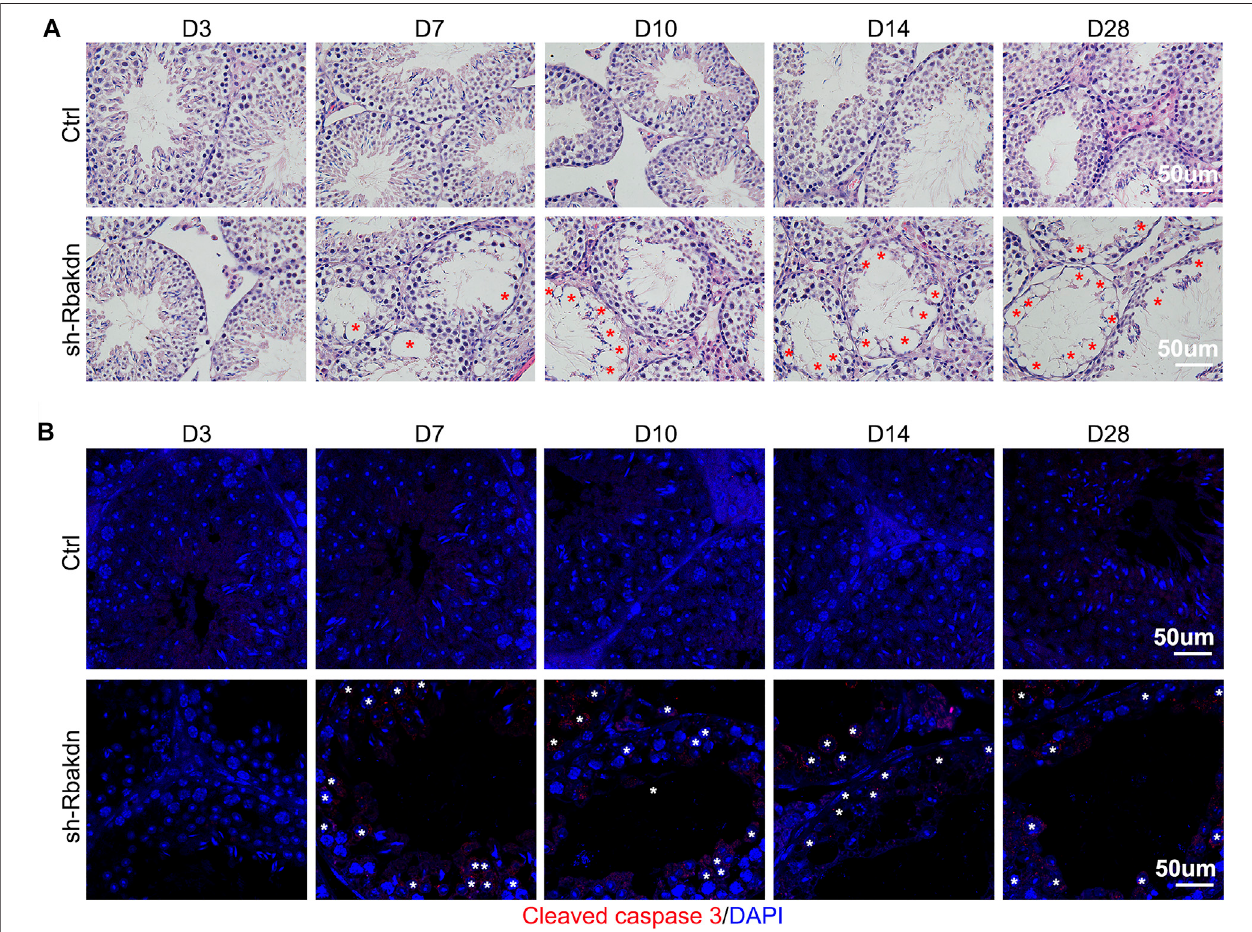
FIGURE 4 | Knockdown of Rbakdn in the testis increased apoptosis of spermatocytes. (A) HE staining of mouse testes after injection of lentivirus-mediated Rbakdn-shRNA at D3,D7, D10,D14, and D28.The redasterisksindicate thevacuoles. (B) Theexpression oftheapoptosis-related protein cleaved caspase-3intestes after injection of lentivirus-mediated Rbakdn-shRNA at D3, D7, D10, D14, and D28. The white asterisks indicate the apoptotic